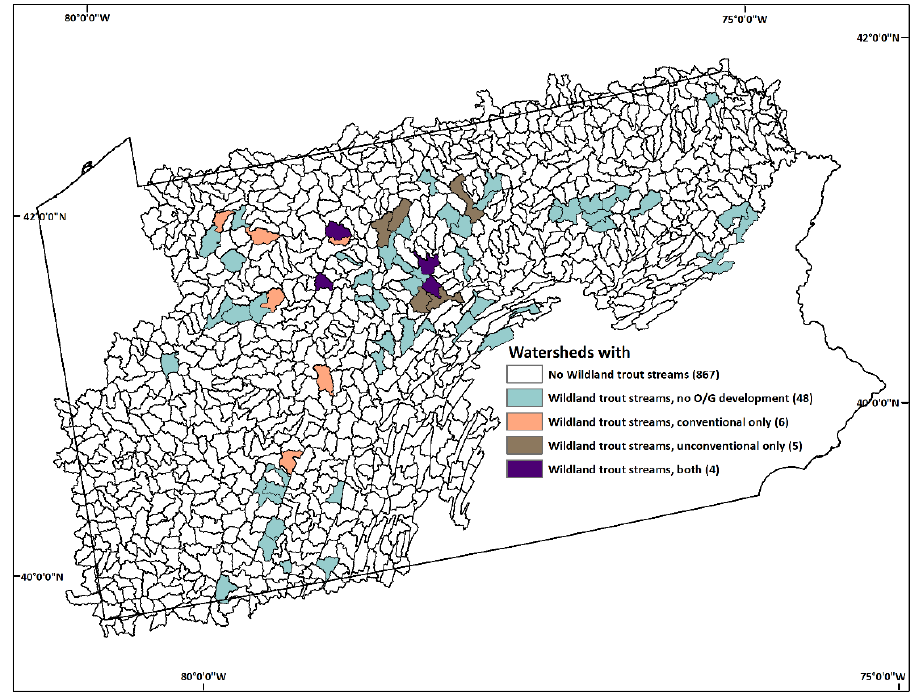
Figure 5. Oil and gas development in the study area in relation to Pennsylvania’s wildland trout streams in the study area. Values in parentheses are the number of watersheds. Some of the watersheds labeled as “No O/G development” in this figure are labeled as having oil and gas development in Figure 3. In these watersheds, the oil and gas development did not occur in the portion of the watershed identified as “of exceptional value” by the State (see